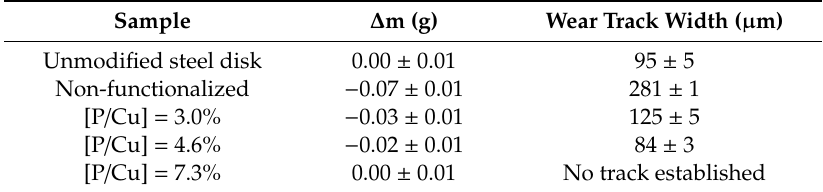
Table 2. Mass change ( ∆ m) compared to sample mass prior to ball-on-disk experiments and wear track width of tool steel.